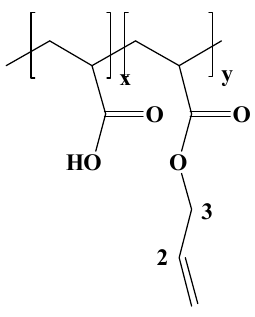
Figure 7. Structure of poly(acrylic acid- co -allyl acrylate) with 1 H-NMR assignment.